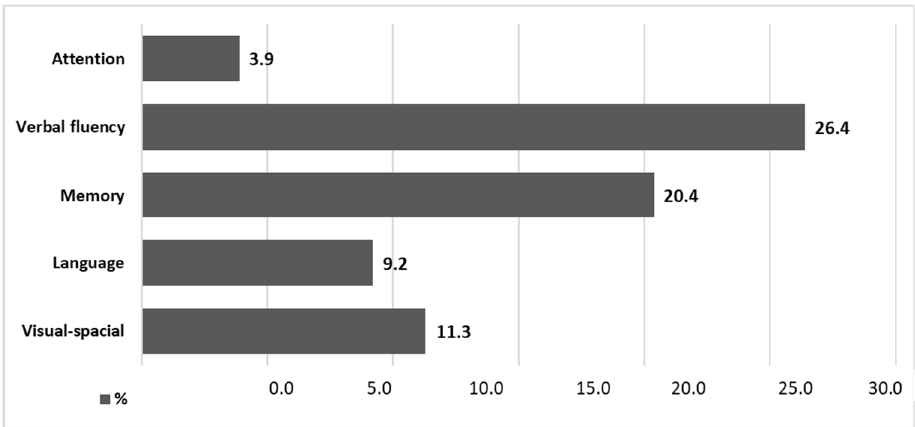
Figure 12. Percentage differences in means between the results within the norm and below the norm for each domain in ACE III (with regard to the scale range of